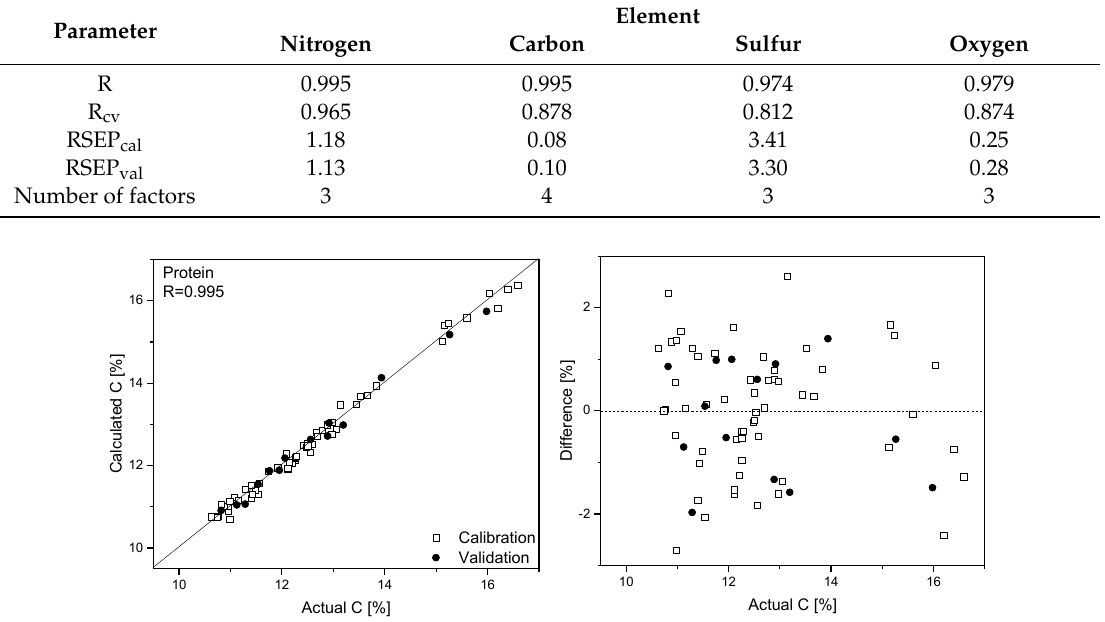
Figure 3. Prediction plot and regression residuals for protein quantification based on Raman spectra.